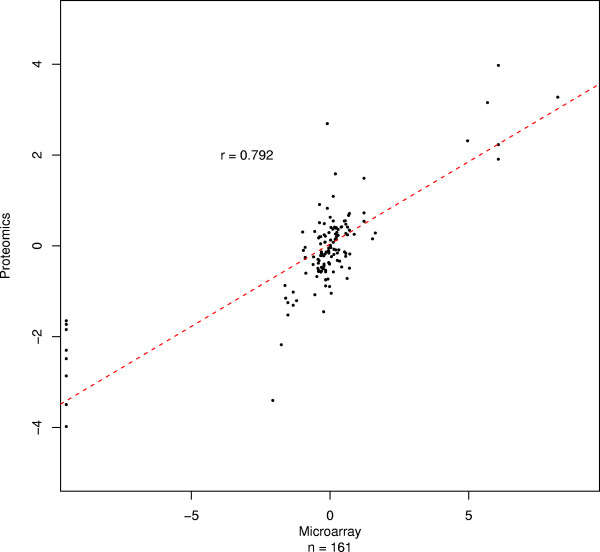
High correspondence between plus2 array and quantitative proteomics data mapped by peptide proximity. Each point corresponds to a matched probeset-peptide pair. A mapping was made when the genomic-origin of a peptide was within 1000 base pairs of the genome location of a microarray probeset. X and Y axes: fold-changes between MCF7 and MCF10A for the microarray data and the quantitative proteomics data, respectively. When more than one matching probeset was found for a given peptide, the mean value was calculated. r: Pearson correlation. n: number of data points. No error bars are shown because no averaging was performed because mapping was based on probeset/peptide location, rather than higher level features such as transcripts or exons, which provide a rationale strategy for grouping the peptides/probesets.